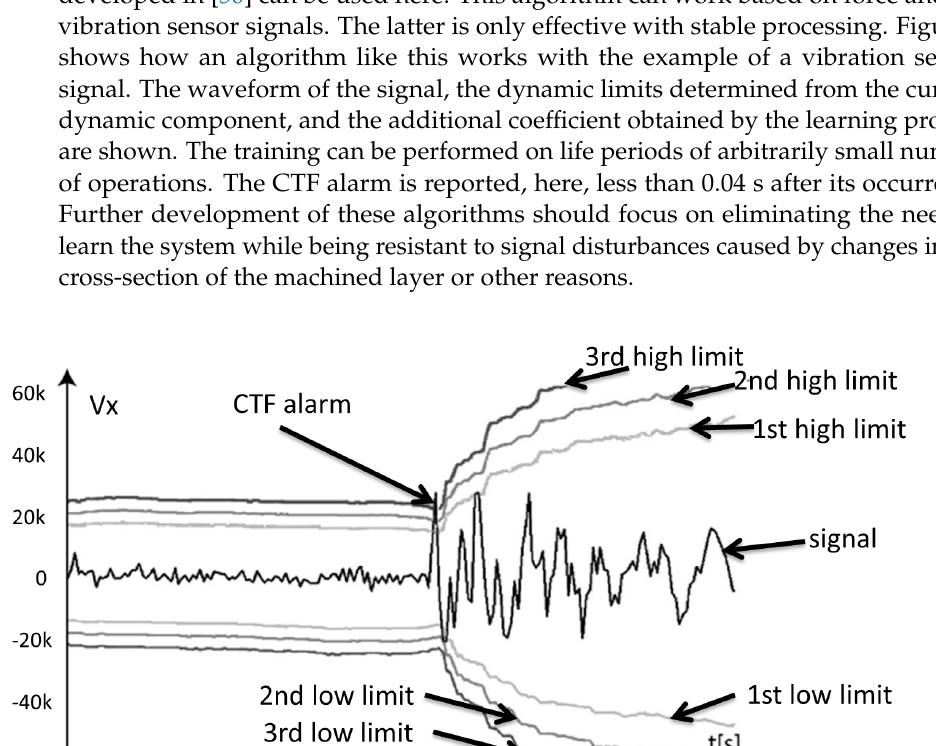
Figure 5. Results of the accelerated tool wear detection algorithm (ATW) [49].